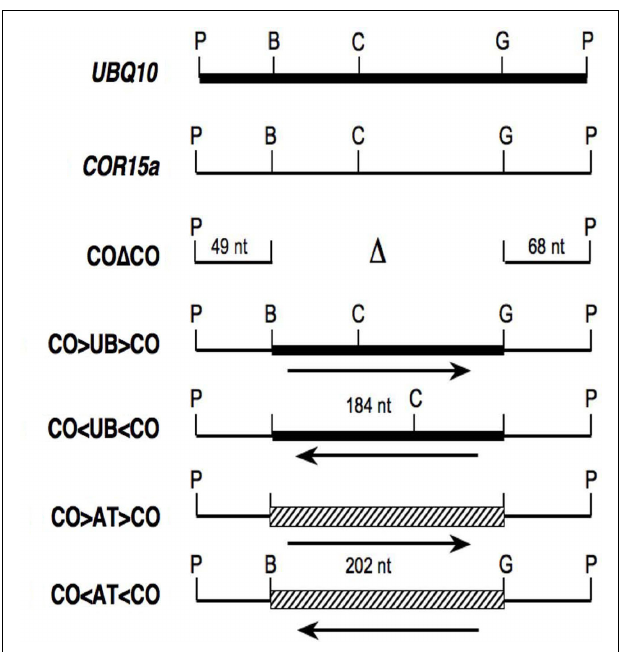
FIGURE 1 | Structure of hybrid introns. Thick lines, thin lines, and the hatched box represent sequences from UBQ10 intron 1, COR15a intron 1, and ATPK1 intron 1 respectively.The letters above vertical lines show the positions of restriction sites for Pst I (P), Bam HI (B), Bcl I (C), and Bgl II (G), while unmarked lines indicate fusions between Bam HI and Bgl II compatible ends.